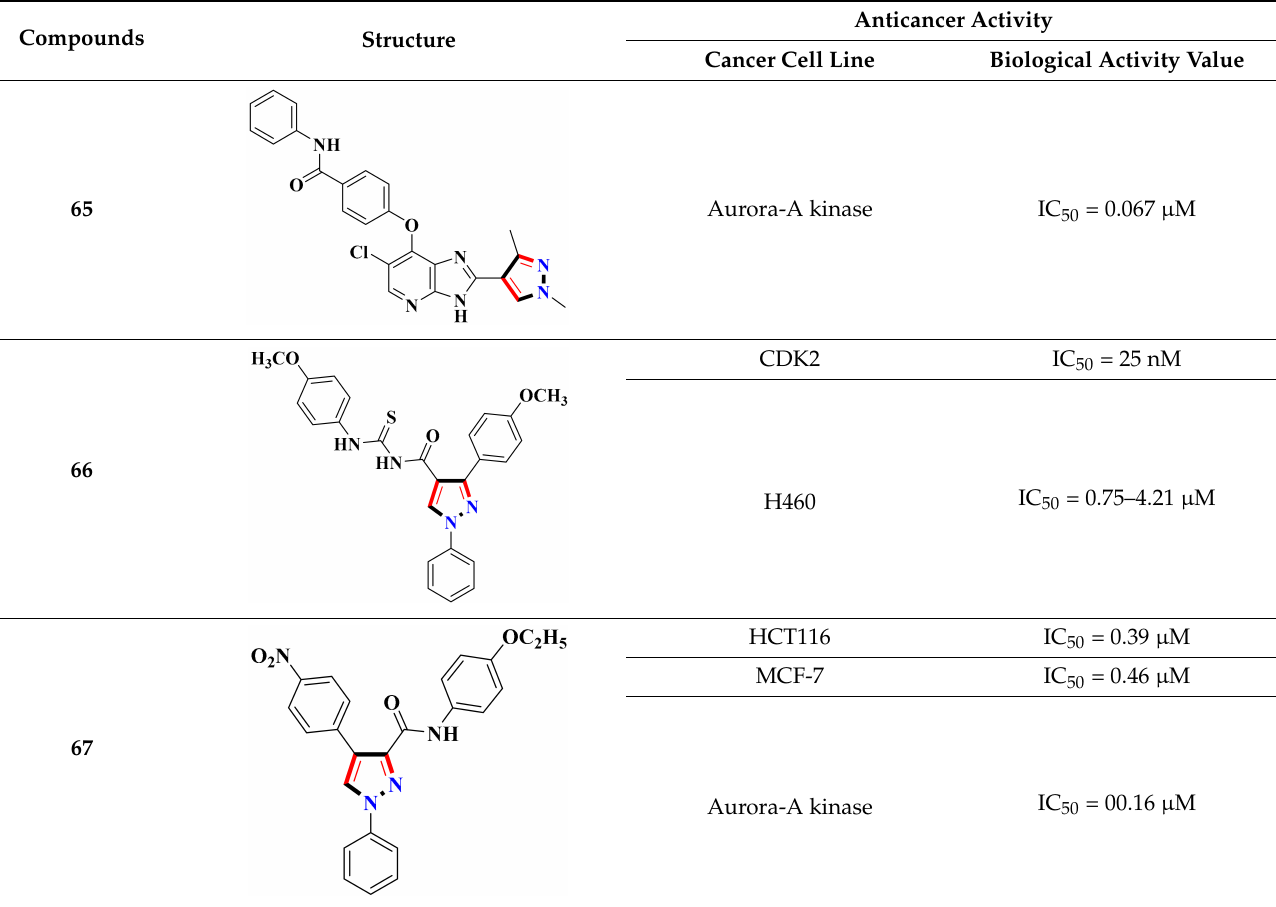
Table 6. Representative compound structures 65 to 81 and their anticancer